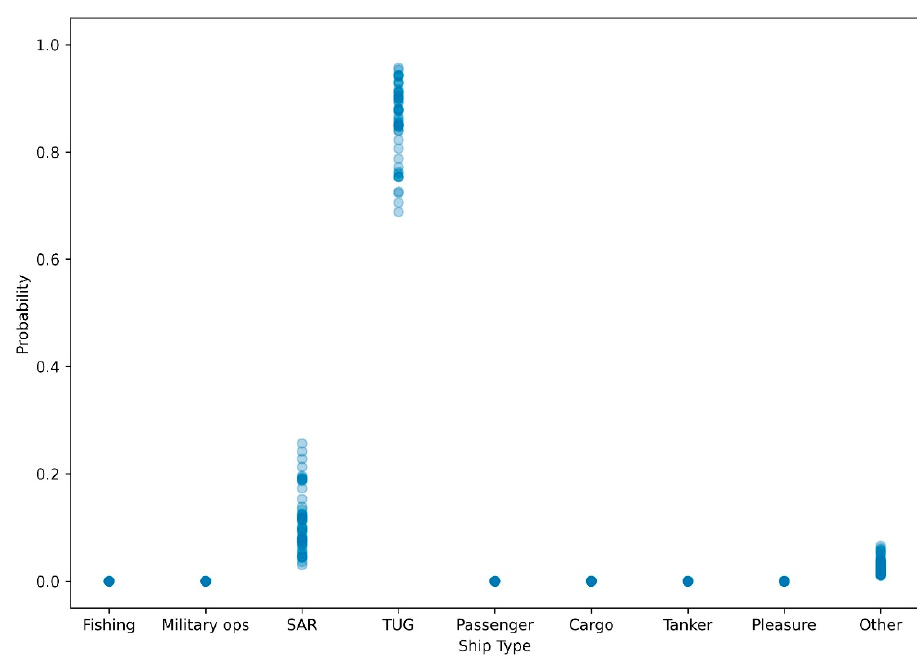
(cid:0) ( T ) , ··· , p t p t i , w t 1